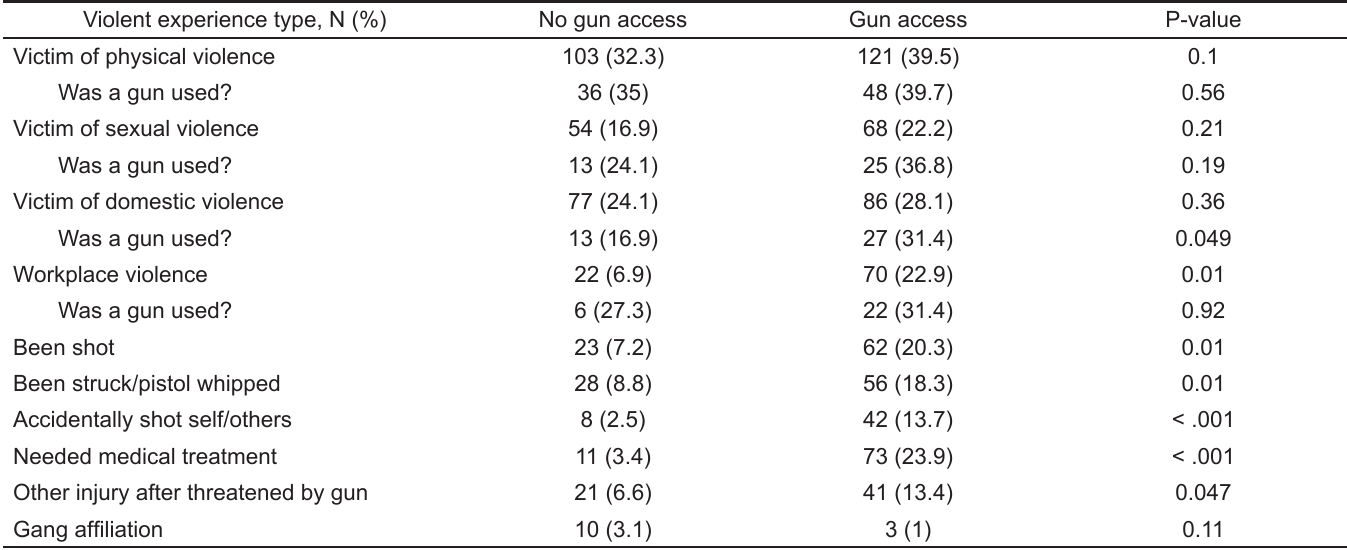
Table 5. History of violence among study patients, gun access vs no gun access.